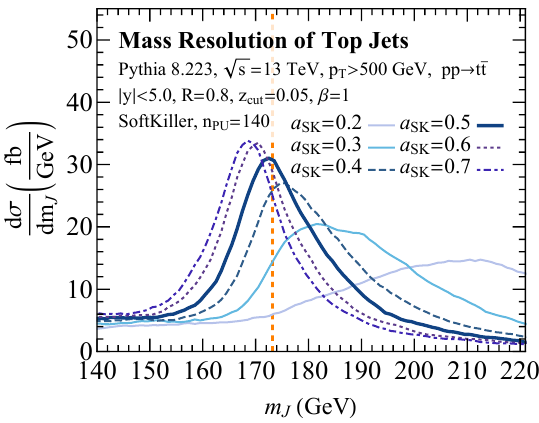
Figure 10. The RSD groomed mass distribution for multiple values of the SK grid parameter a SK .